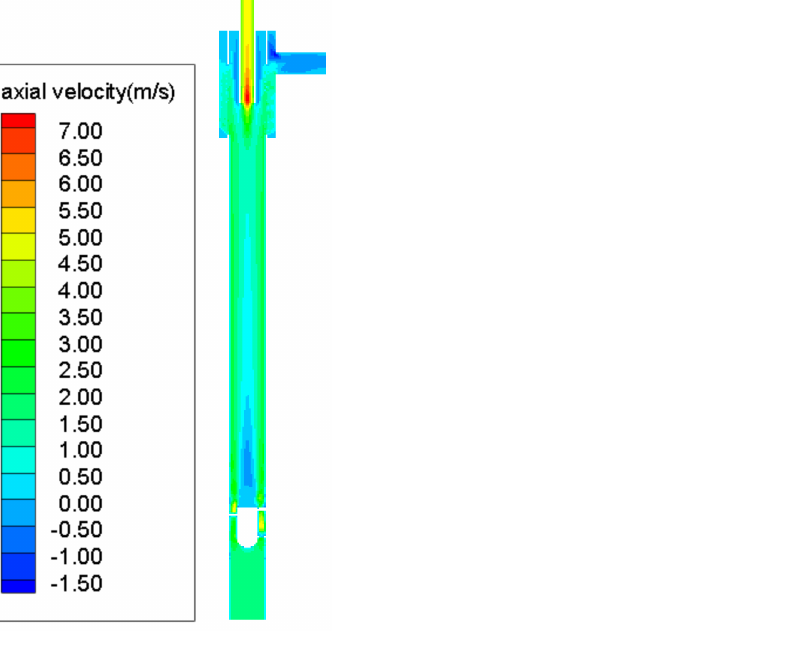
Figure 5. Distribution cloud of axial velocity inside the separator.